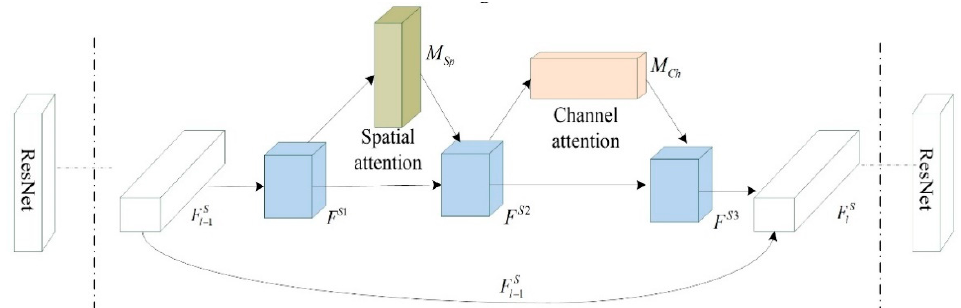
Figure 2. Basic structure of the scattering transform attention mechanism.